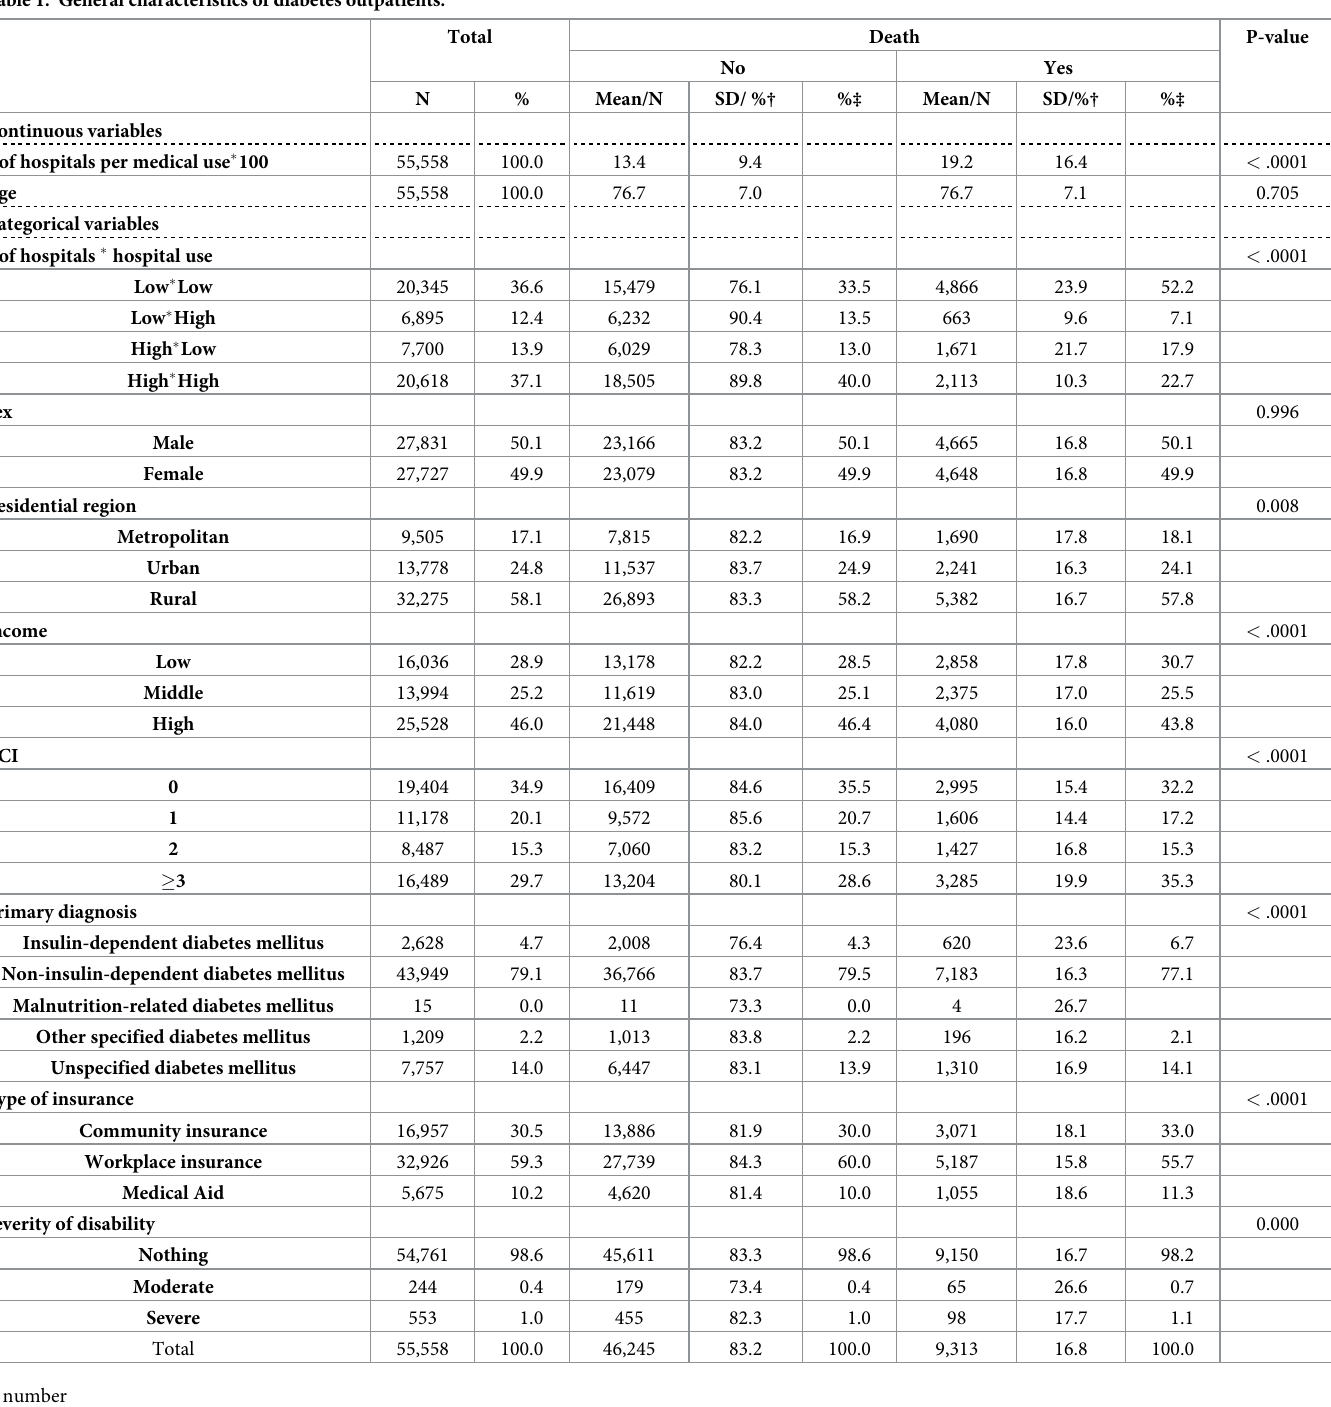
Table 1. General characteristics of diabetes